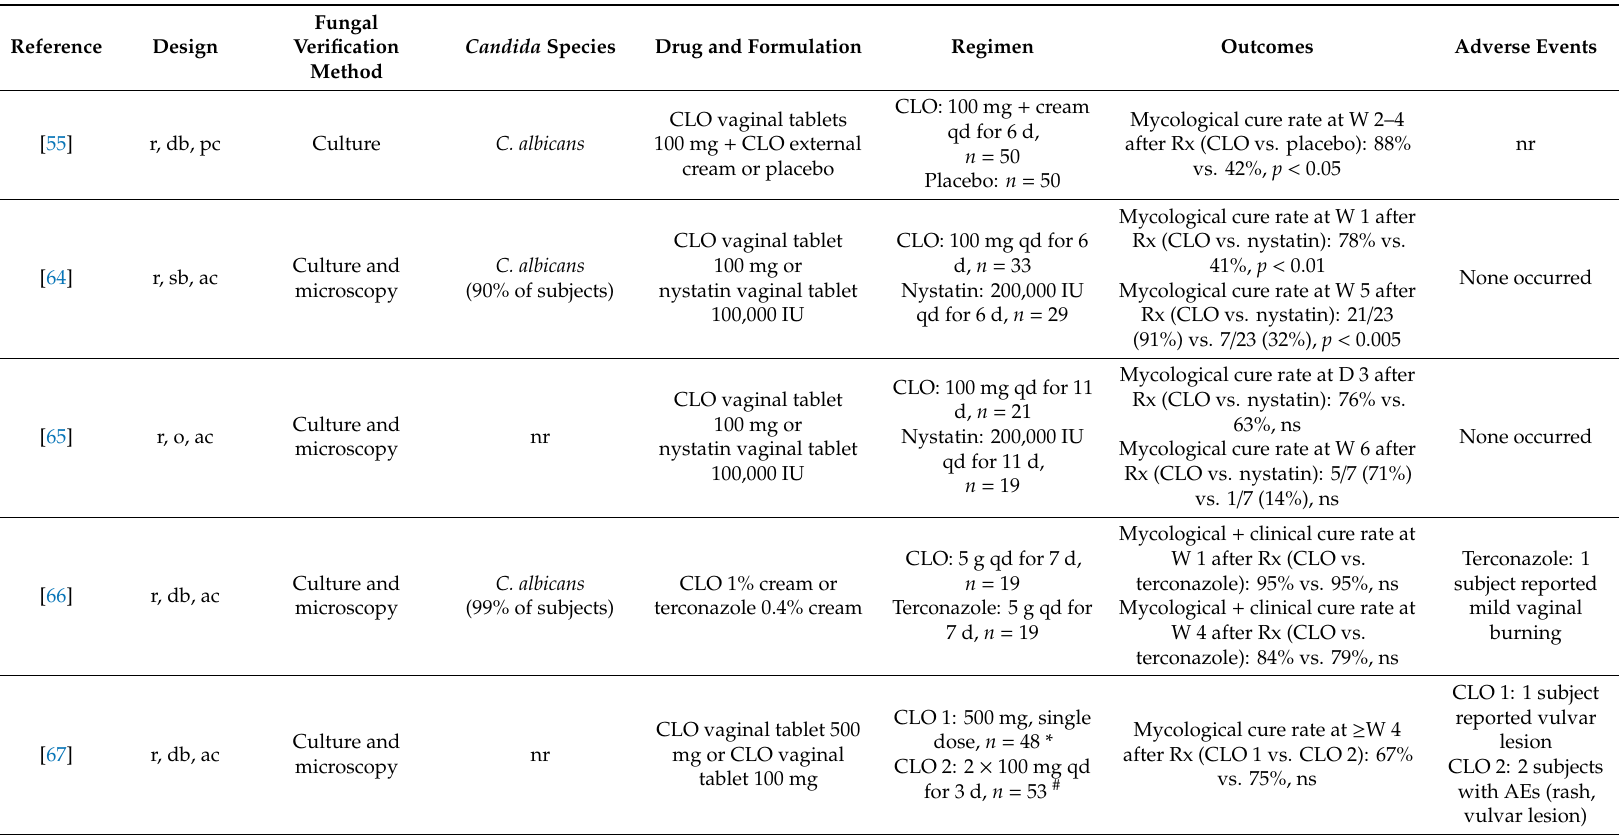
Table 3. Randomized controlled studies investigating intravaginal clotrimazole in pregnant women with symptomatic vulvovaginal